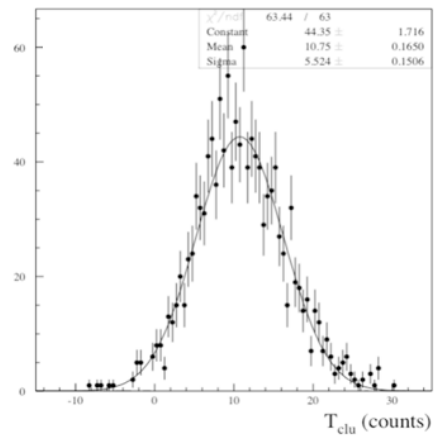
Figure 8. Time resolution measurement performed illuminating the CCALT crystals with 100 MeV electrons at the Frascati Beam Test Facility.